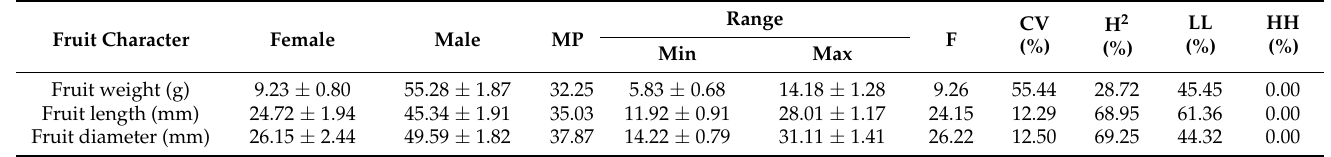
Table 3. Estimates of variability and genetic parameters for fruit characteristics in 101 hybrids and their